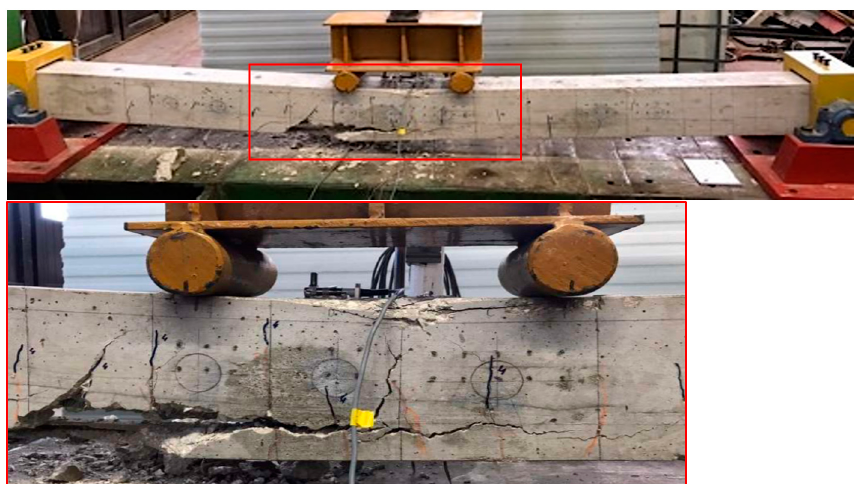
Figure 5. Failure mode of specimen B2 CFRP .